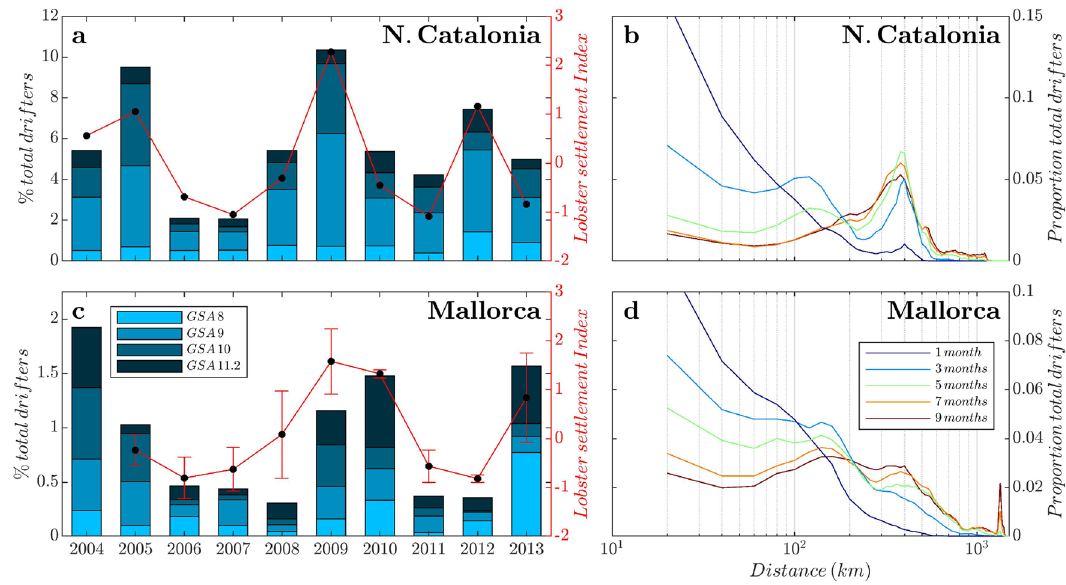
Figure 2. Spatiotemporal connectivity patterns and dispersal kernels. Comparison of observed LSI anomalies for NCat and Mallorca (red line, Panels a and c , errors are 1 SD) vs. percentage of individuals arriving from adult lobster habitat GSAs (0–200 m) (blue bars) (Fig. 1). The percentage of individuals was averaged over the settlement season (May to August) to compare with settlement field records. Correlations LSI vs. total % individuals from GSAs (8, 9, 10, 11.2): NCat ( r = 0.89 ; p-value = 0.0003 ; n = 10 ); Mallorca ( r = 0.81 ; p-value =